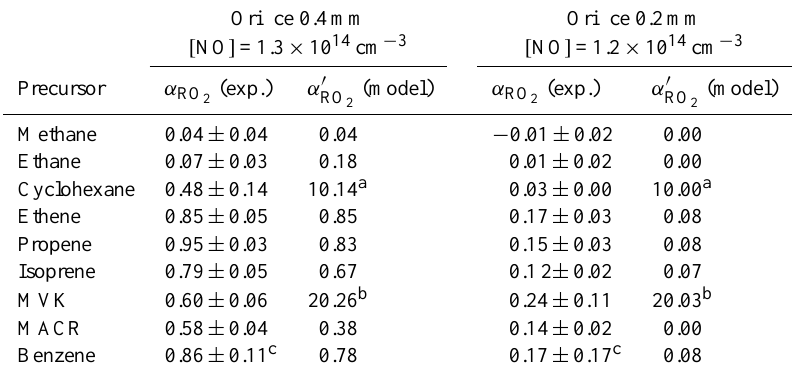
Table 2. Measured and calculated relative detection sensitivities of different RO 2 species in the HO 2 detection cell for two inlet configura- tions. Modeled values are calculated from the ratio of conversion efficiencies that are achieved for RO 2 and HO 2 ( α 0 γ RO = γ HO (Eq. 11). The sensitivity applies for RO 2 that is produced in the reaction of organic precursors with OH and O 2 . 2 2